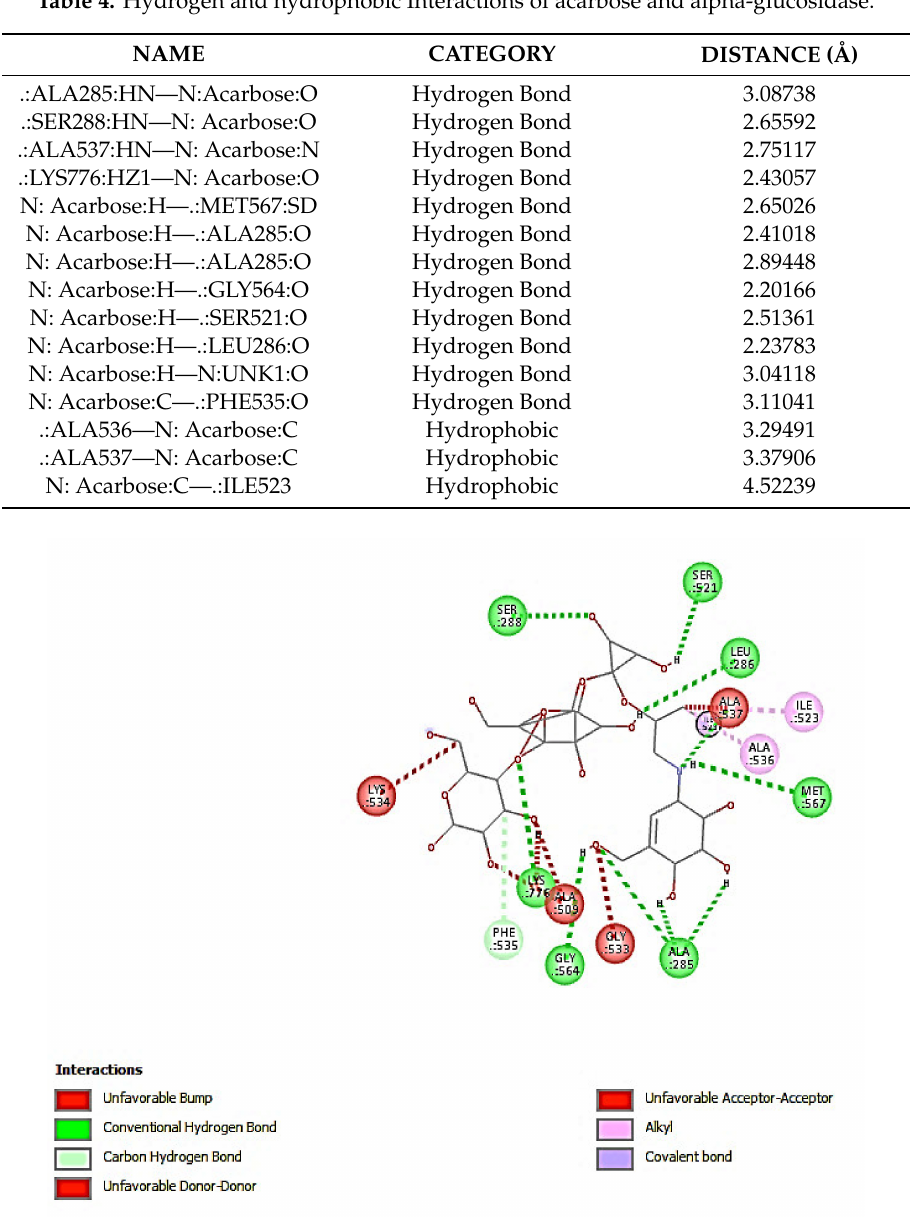
Figure 3. Interaction of acarbose with amino acid residues of